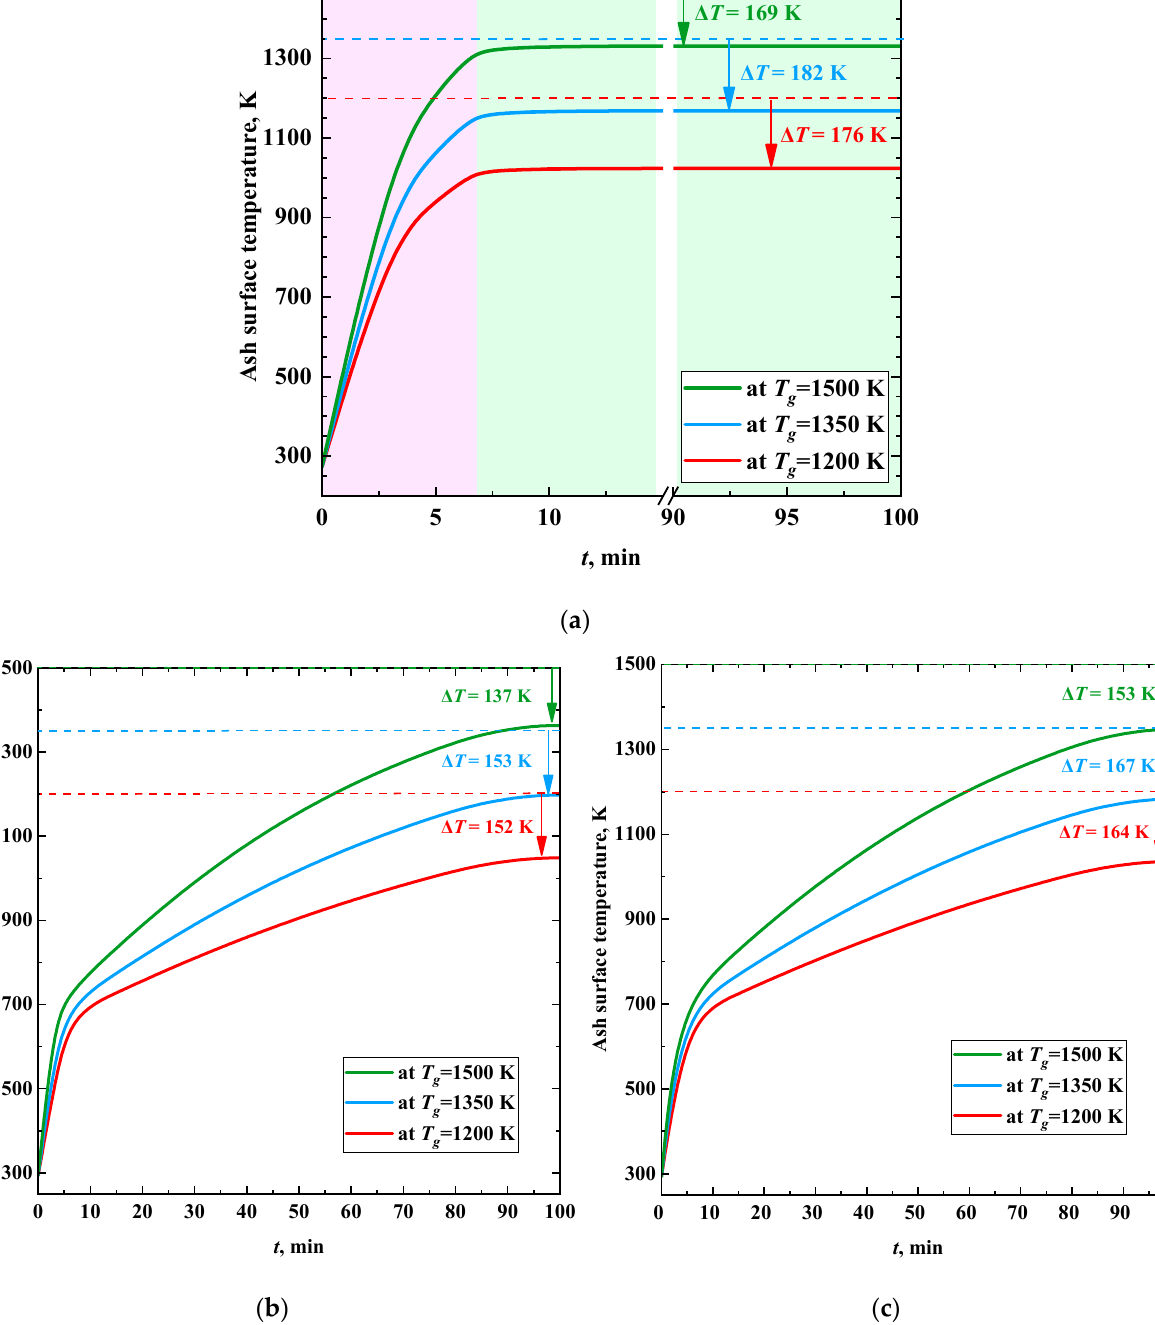
Figure 10. Ash surface temperature trends when burning different fuels: ( a ) coal, ( b ) CWS, ( c ) CWSP.